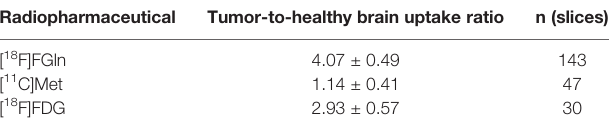
TABLE 3 | Autoradiography analysis result summary.